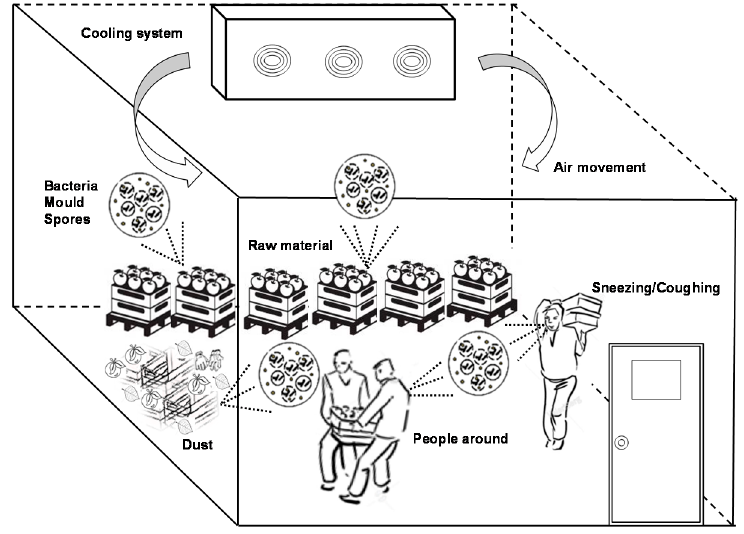
Figure 1. Schematic design of air contamination sources in a fruit cold storage room.